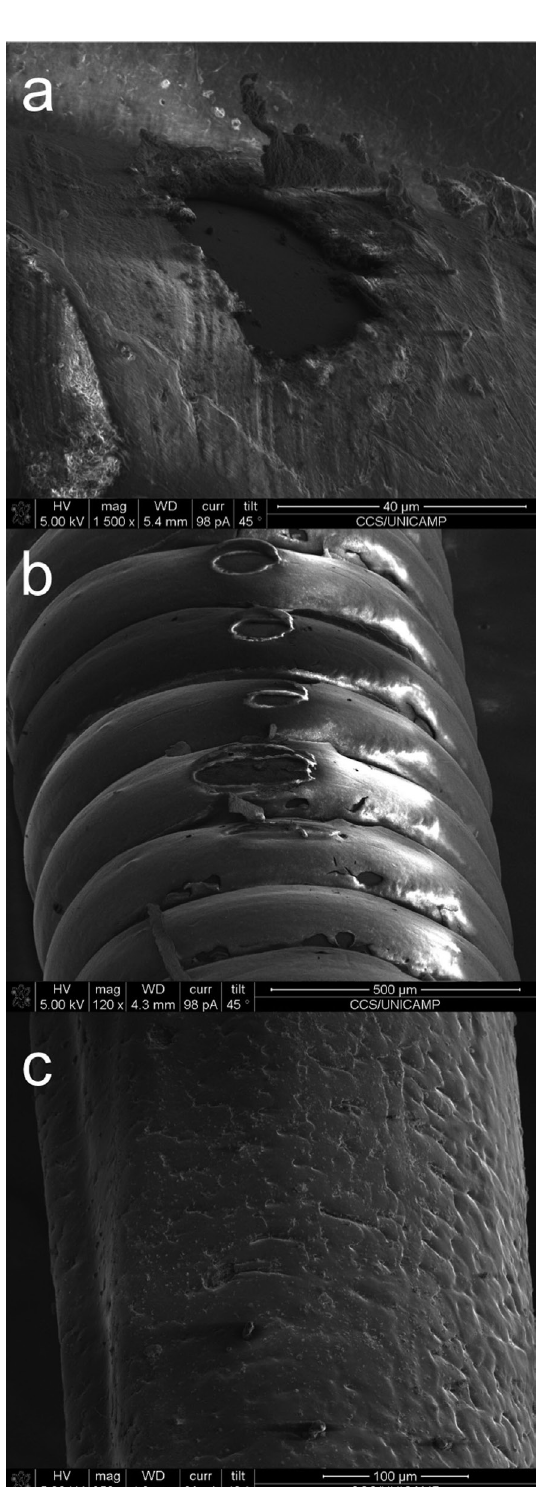
Fig. 3 – SEM images of guide wires AU2, BU2 and CU2, washing 2X using enzymatic detergent in ultrasonic bath. Persistence of debris and holes in Figures A and B and an increase in roughness is observed in Figure